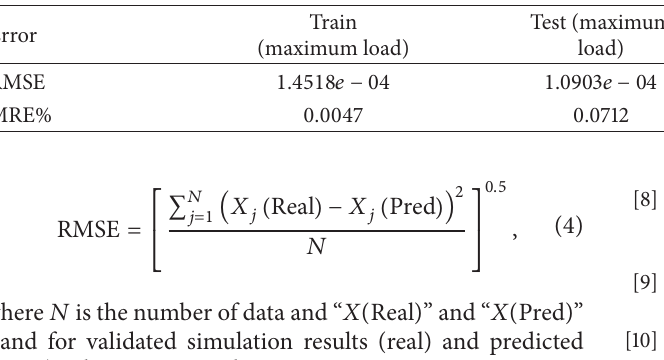
Table 5: Obtained errors for training and testing results of the proposed ANN